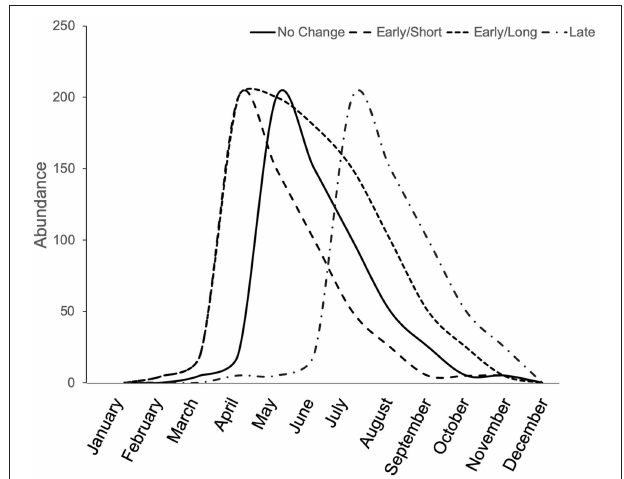
FIGURE 3 | Conceptual illustration of phenological shifts due to the urban heat island effect. Depending on the species’ thermal optima and tolerance, the urban heat island effect can result in no change from the natural emergence time (solid line), earlier emergence, potentially with a shorter season (long dash), earlier emergence with an extended season (short dash), or a late emergence, potentially with a shorter season